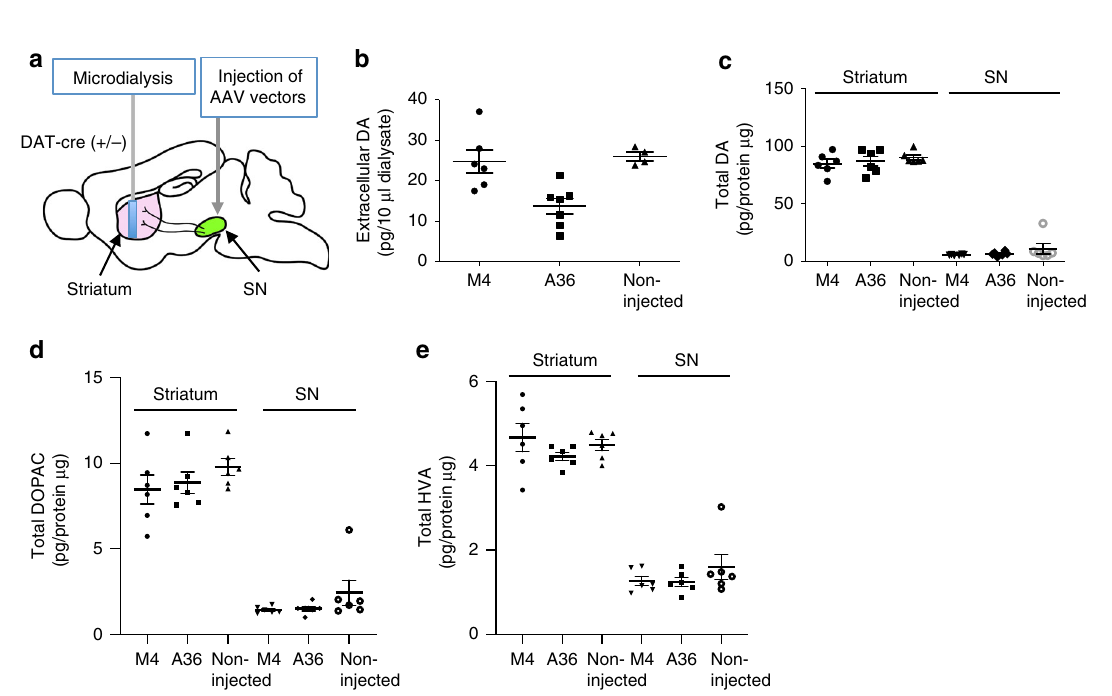
Fig. 6 Inhibition of the function of Syt I by STAND-A36 expression in vitro. a Binding of puri fi ed STAND-A36 to indicated GST-fused proteins, as determined by an enzyme-linked immunosorbent assay ( n = 3 independent samples per group). Statistical analysis: two-tailed one-way ANOVA: absorbance, F (2, 6) = 3497, P < 0.00001; Tukey ’ s multiple comparison test: GST-C2A vs. GST-C2B: P < 0.00001, GST-C2A vs. GST: P < 0.00001, GST vs. GST-C2B: P = 0.98987). b Western blot analysis of total mouse brain homogenates using puri fi ed STAND-A36 as a primary antibody. c Intracellular interaction of STAND-A36, but not of STAND-M4, with Syt I expressed in 293 T cells co-transfected with Syt I-expressing vector and indicated vectors. Immunoprecipitates obtained using anti-HA antibody were analysed using western blotting with an anti-Flag antibody to detect scFv and anti-Syt I antibodies. d Decreased interaction of Syt I with the Syx1B-SNARE domain by the expression of STAND-A36. The cell lysate described in c was incubated with puri fi ed GST or GST-Syx1-SNARE, then subjected to immunoprecipitation with the anti-GST antibody. Immunoprecipitates were analysed using western blotting with an anti-Syt I antibody. e Quanti fi cation of the relative amount of Syt I protein co-immunoprecipitated with GST-Syx1-SNARE described in d ( n = 8 independent experiments per group). Statistical analysis: Mann-Whitney U test, P = 0.0021645. f – h STAND-A36 expression in cultured dopamine neurons inhibited high potassium-induced dopamine release. f Fluorescent images of dopaminergic neurons (DIV 14) expressing STAND-A36 (upper panels) and STAND-M4 (lower panels) (Left: anti-HA antibody to detect STAND proteins; middle: anti-TH antibody to detect dopaminergic neurons, right: merged images of left and middle panels). Arrows show dopaminergic neurons, which did not express STAND proteins. Scale bar, 20 μ m. g Transfection ef fi ciency of STAND proteins in dopaminergic neurons. h Measurement for high potassium-induced dopamine release normalised with a low potassium-induced one in cultured dopamine neurons. Statistical analysis: two-tailed t -test, P = 0.0311. Error bars represent standard error of the mean. Source data are provided as a Source Data fi le.